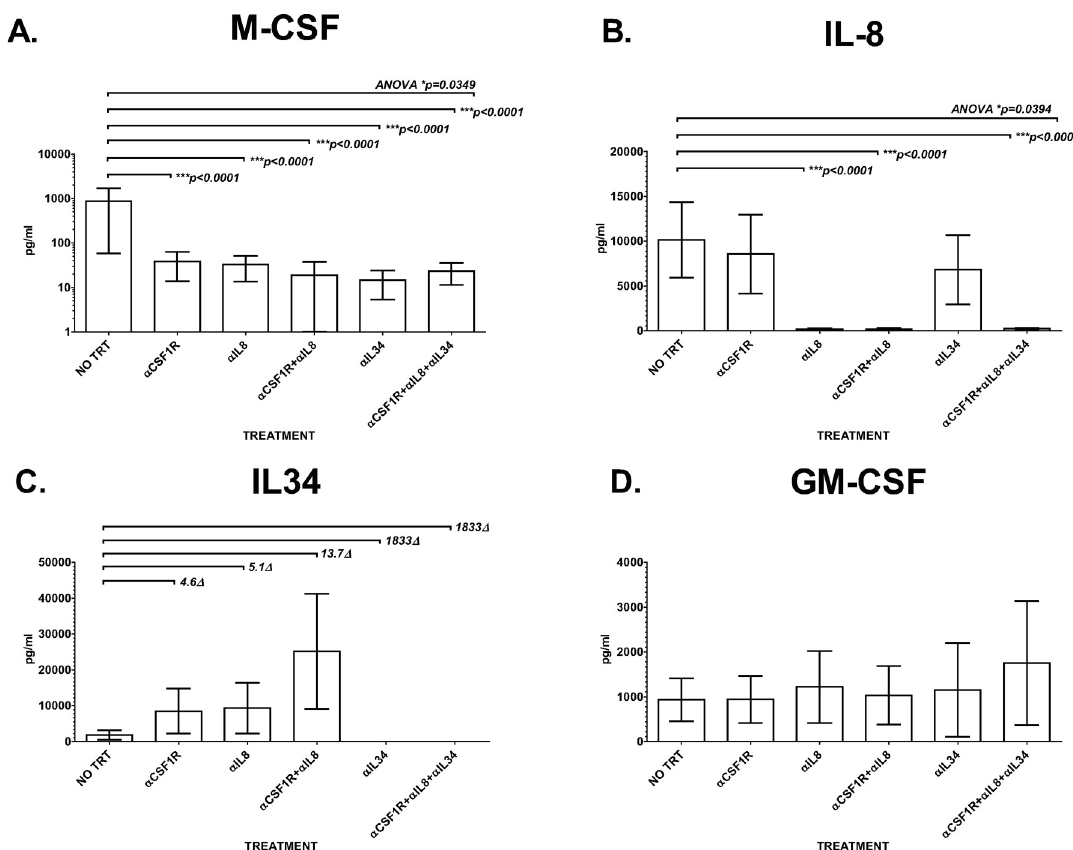
Fig 5. High M-CSF, IL-8, IL-34, and GM-CSF levels were found in conditioned media from 7-day PDAC PortalBMC cultures. Culture media supernatants from 7 day cultures of 8 PDAC patients ex vivo PortalBMC were analyzed in duplicate by ELISA for ( A ) M-CSF, ( B ) IL-8, ( C ) IL-34, and ( D ) GM-CSF. Untreated cultures had elevated levels of M-CSF and IL-8 and comparable levels of IL- 34 and GM-CSF compared to PDAC portal blood plasma and elevated levels of all 4 analytes compared to healthy human plasma analyzed by ELISA ( Fig 2A ). ( A ) Treatment with 4mg/kg humanized anti-CSF1R (BMS-986227, Cabiralizumab) suppressed production of M-CSF (CSF1). Treatment with 10mg/kg humanized anti-IL-8 (BMS-986253), suppressed CSF1( A ) and IL-8 ( B ) production. Combined 10mg/kg anti-IL-8 /4mg/kg anti-CSF1R or 10mg/kg anti-IL-8/4mg/kg anti-CSF1R/4mg/kg anti-IL-34 treatments enhanced these effects. ( C ) Cultures treated with anti-IL34 antibodies alone or in combination suppressed M-CSF and IL-34 production. ( D )No treatment significantly altered the GM-CSF levels seen in these cultures. The p values for significantly different pairwise and ANOVA comparisons are listed by the brackets indicating the test groups compared to untreated cultures ( NO TRT ). Bars depict mean of values and error bars indicate standard error from the